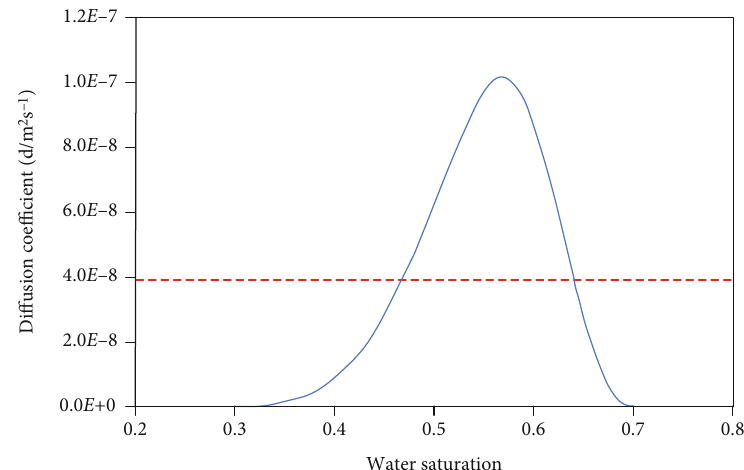
Figure 2: Relationship curve of the capillary di ff usivity coe ffi cient and water saturation (the dotted line is the average capillary di ff usivity coe ffi cient ’ s